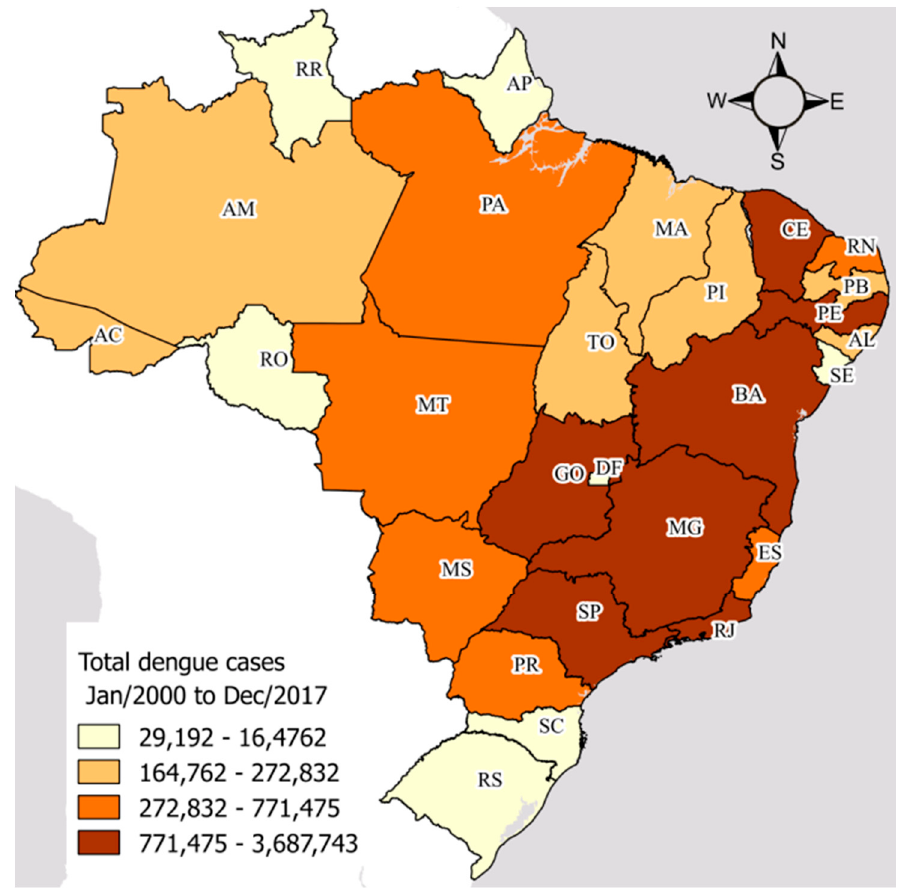
Figure 1. Distribution of total dengue cases from January 2000 to December 2017 across the study sites: states and federal district of